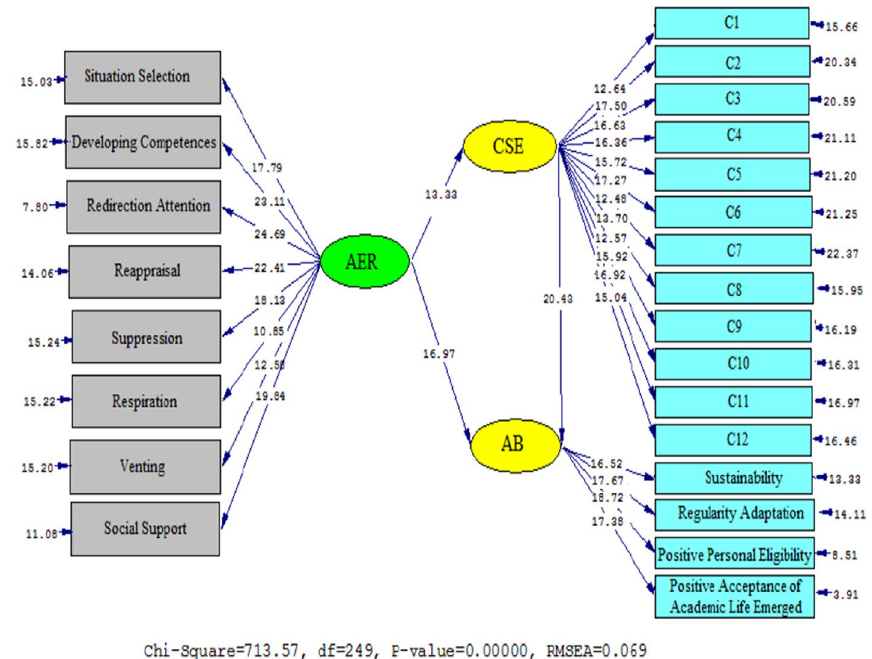
Fig. 3 T ‑values for path coefficient significance (model